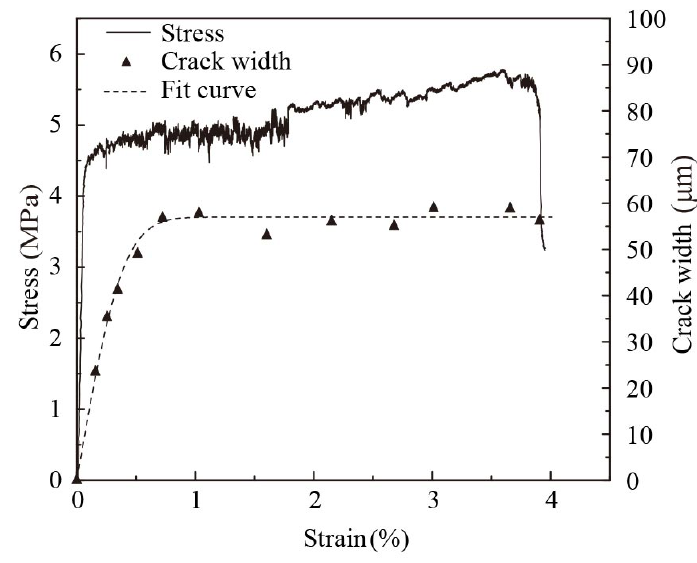
Figure 1. A typical uniaxial tensile stress-strain curve of ECC